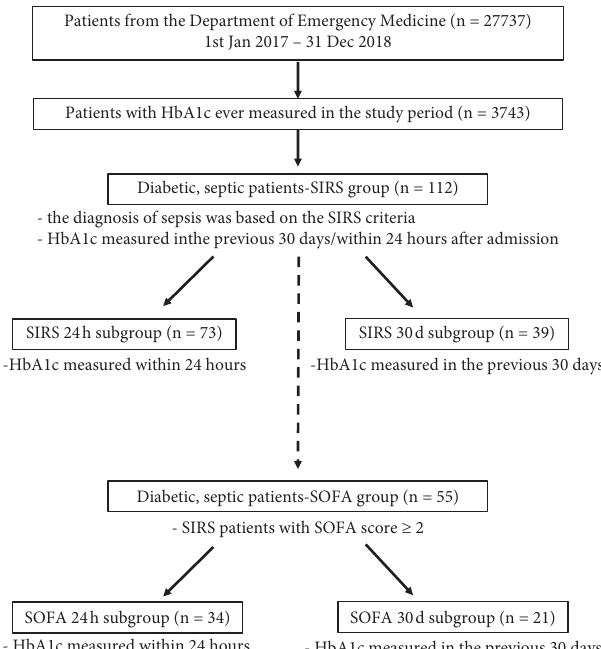
Figure 1: Flowchart showing the structure of the study, enrolment, and evaluation procedure, and how the patients were divided into groups and